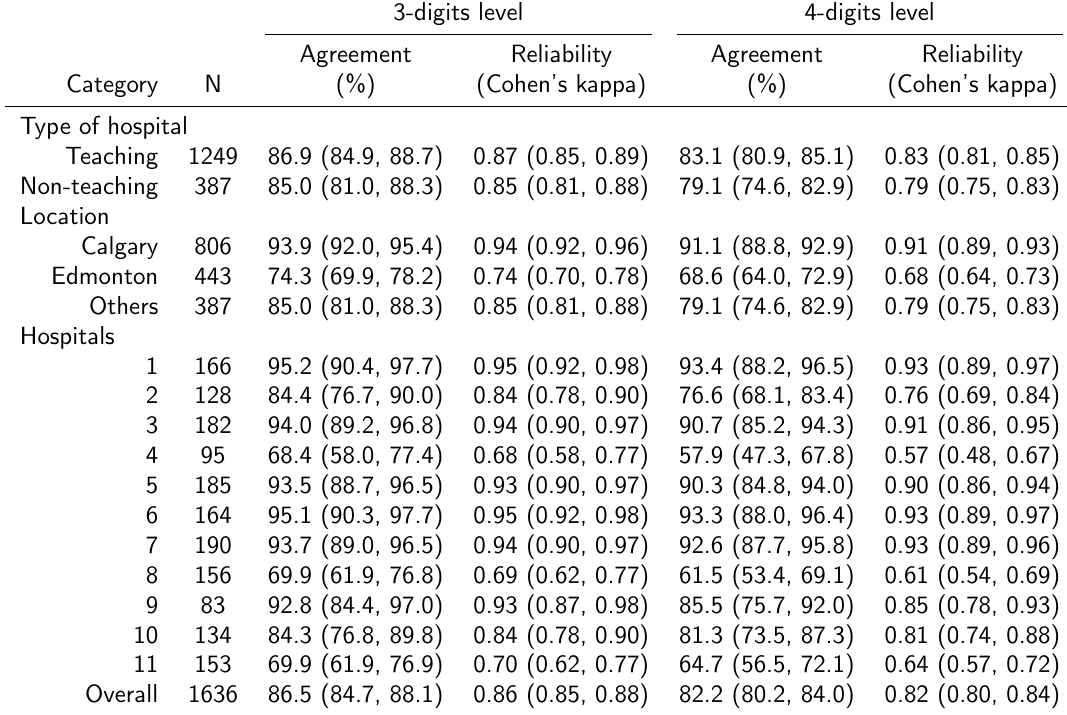
Table 1: Overall agreement and reliability for coding at 3 and 4 digit